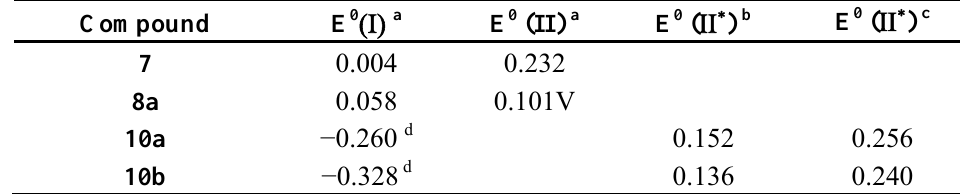
Table 2. Formal electrode potential E 0 (I), E 0 (II) and Δ E 0 (II-I), and constant K compounds 7 , 8a , 10a , and 10b